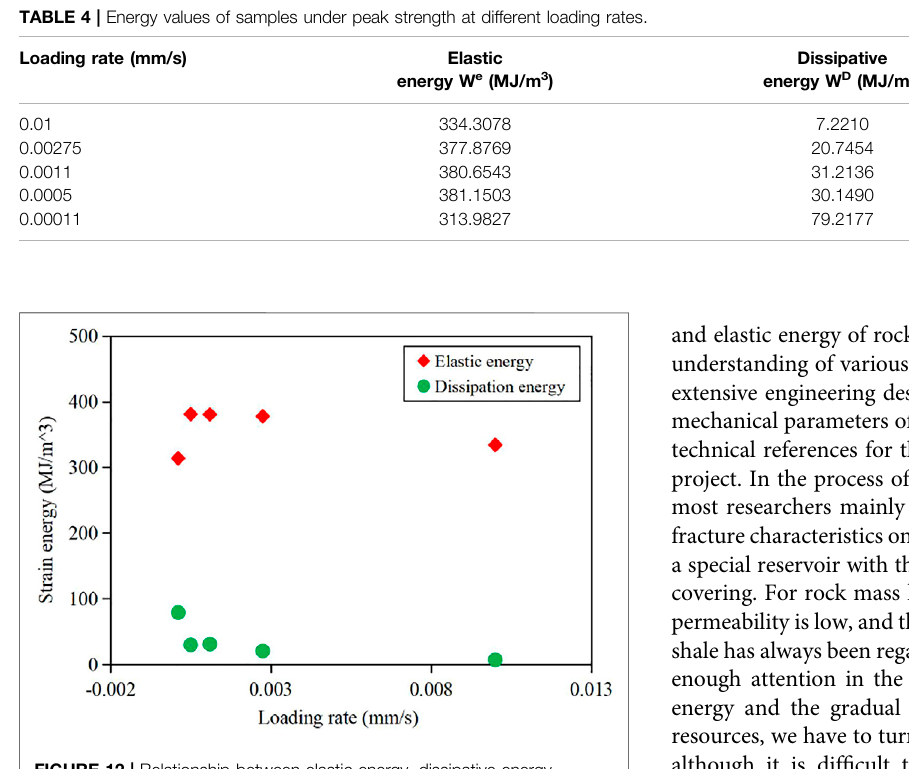
FIGURE 12 | Relationship between elastic energy, dissipative energy, and loading